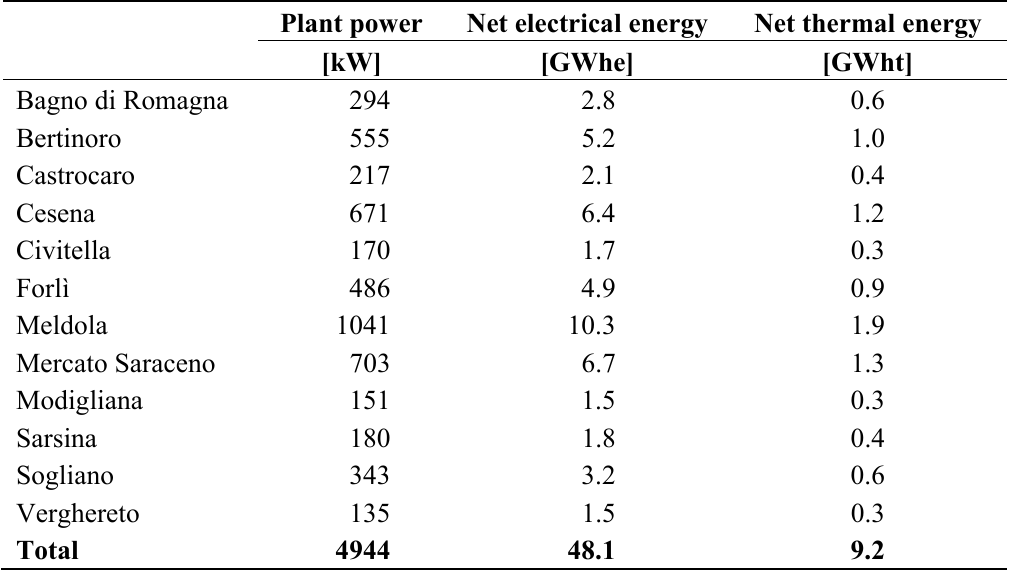
Table 10. Results of the optimal use of biomass in single parcel plants (yearly